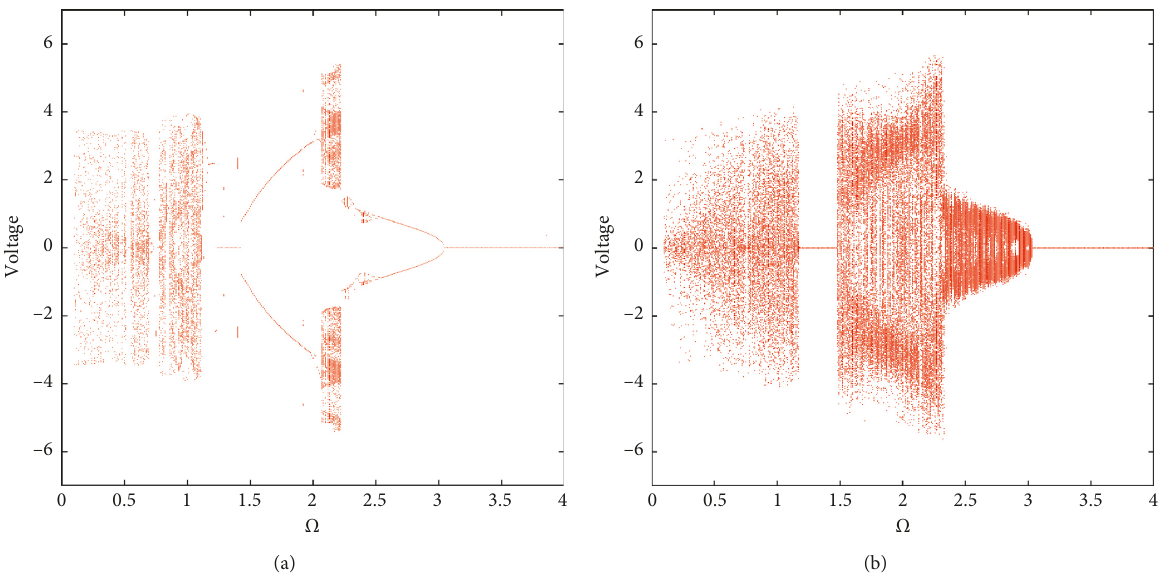
Figure 8: Bifurcation diagram of the output voltage with the variation in Ω : (a) c � 0 . 0; (b) c � 0 .